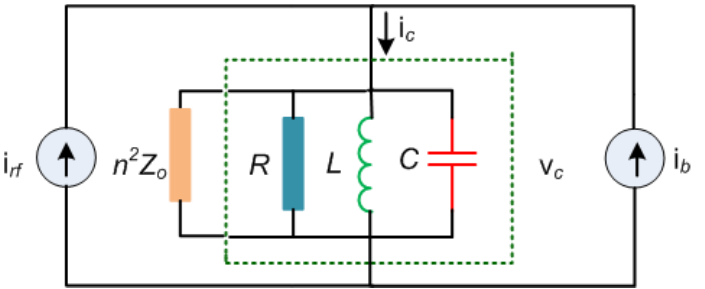
Figure 2. Accelerator cavity circuit model with beam current, input coupler and RF